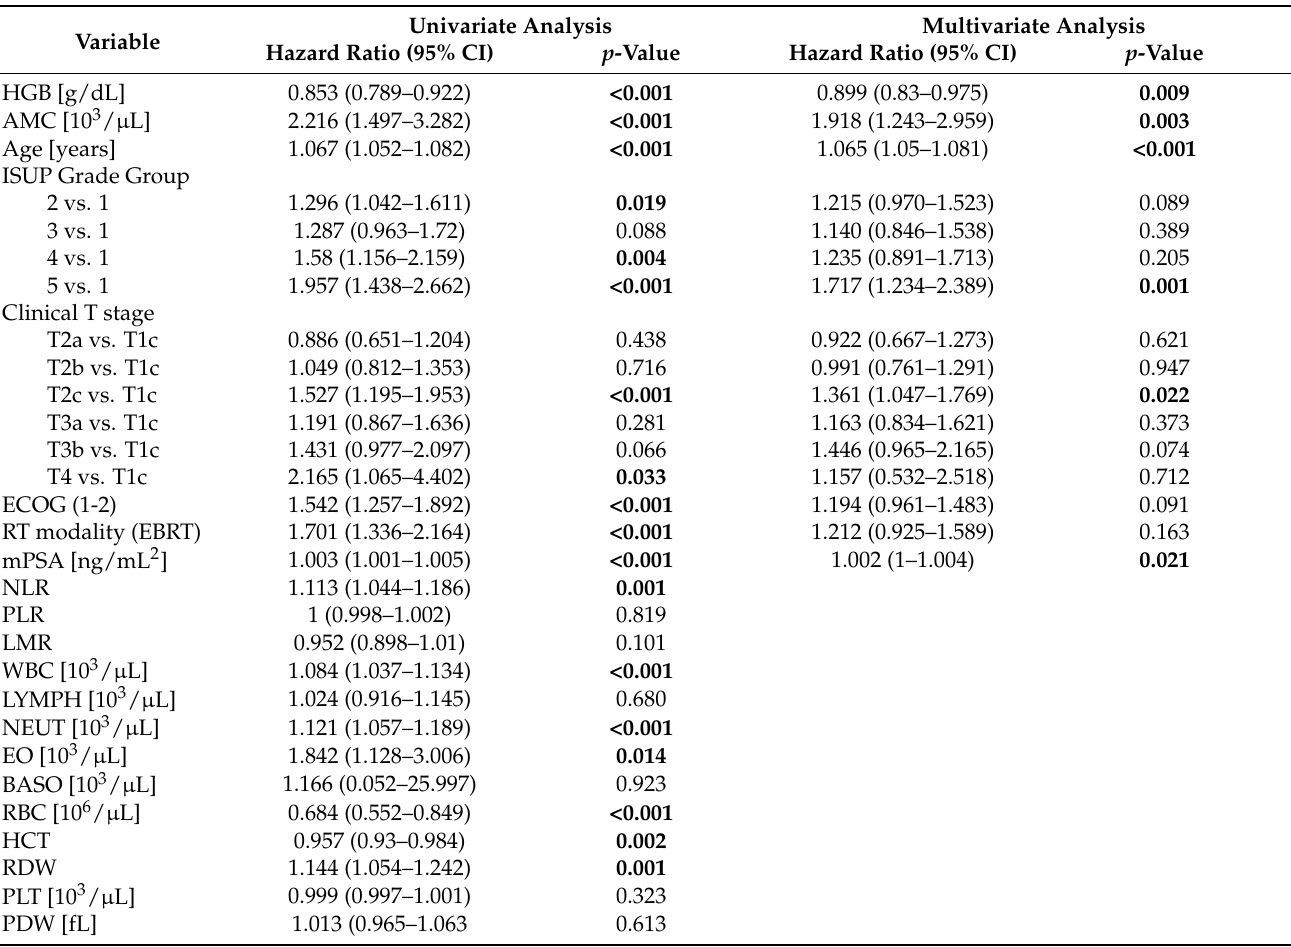
Table 2. Cox Proportional Hazards Regression Analysis for overall survival in patients treated with radiation therapy for localized or locally advanced prostate